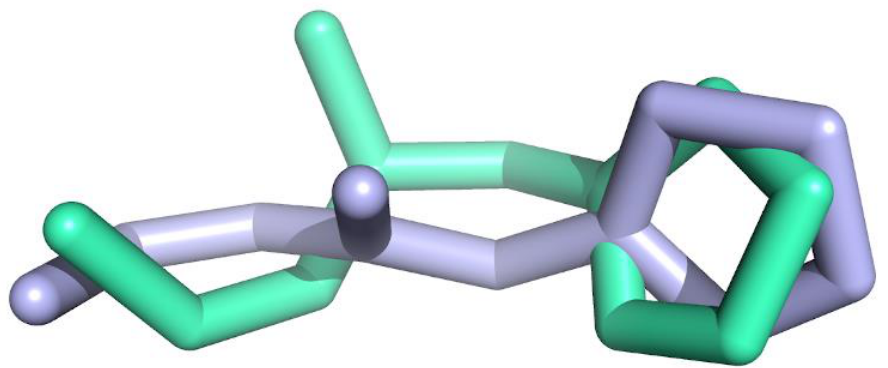
Figure 5. The superposition of the Glide-docked F2M pose (blue color) and its native conformation (green color) in 5MRL. The RMSD for heavy atoms of F2M is 1.048 Å. Picture made by PYMOL [32] .